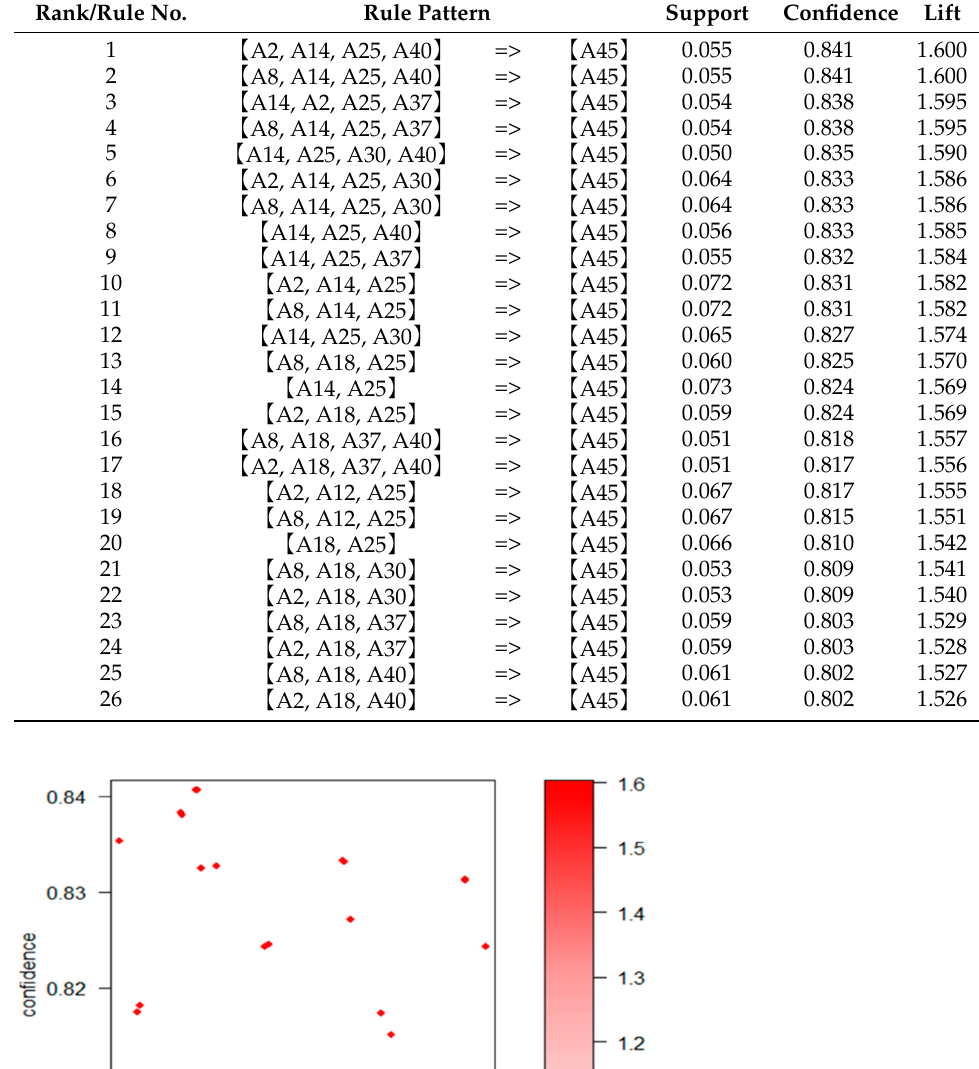
Table 4. The 26 association rule sets by sorting confidence for healthcare needs (A45: provide medical allowances).